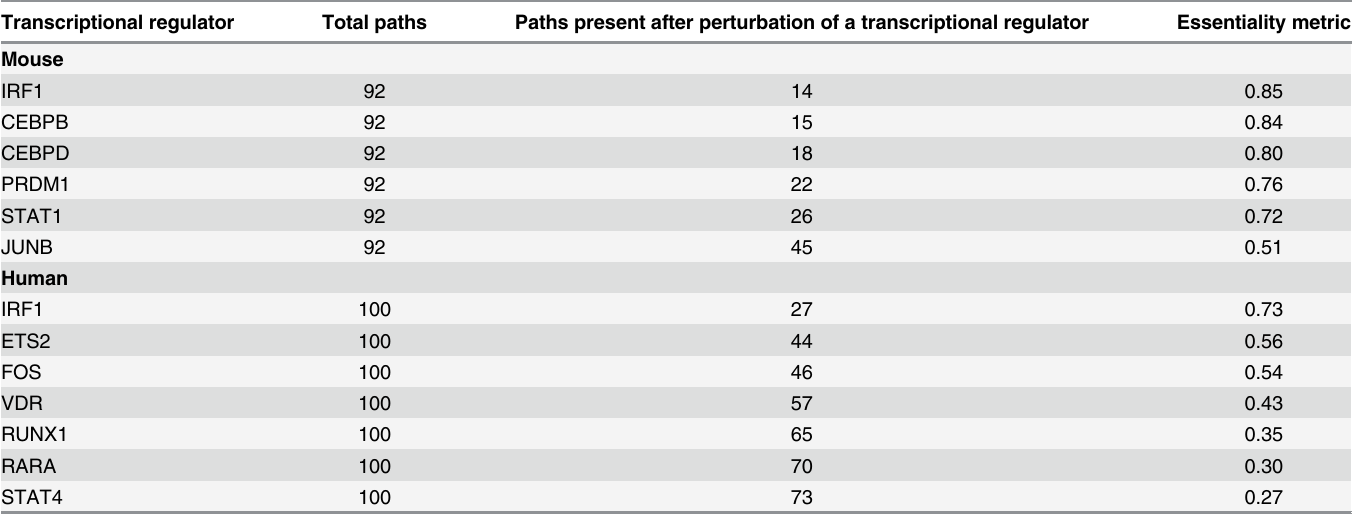
The gene essentiality metric scores were calculated from the mouse and human simple paths networks. Columns description: (1) transcription factor, (2) total number of paths from the simple paths network ( Np ), (3) paths present when a particular transcription factor is perturbed (absent) ( N j ), (4) essentiality metric score calculated as EMj = ( Np - N j )/ N j